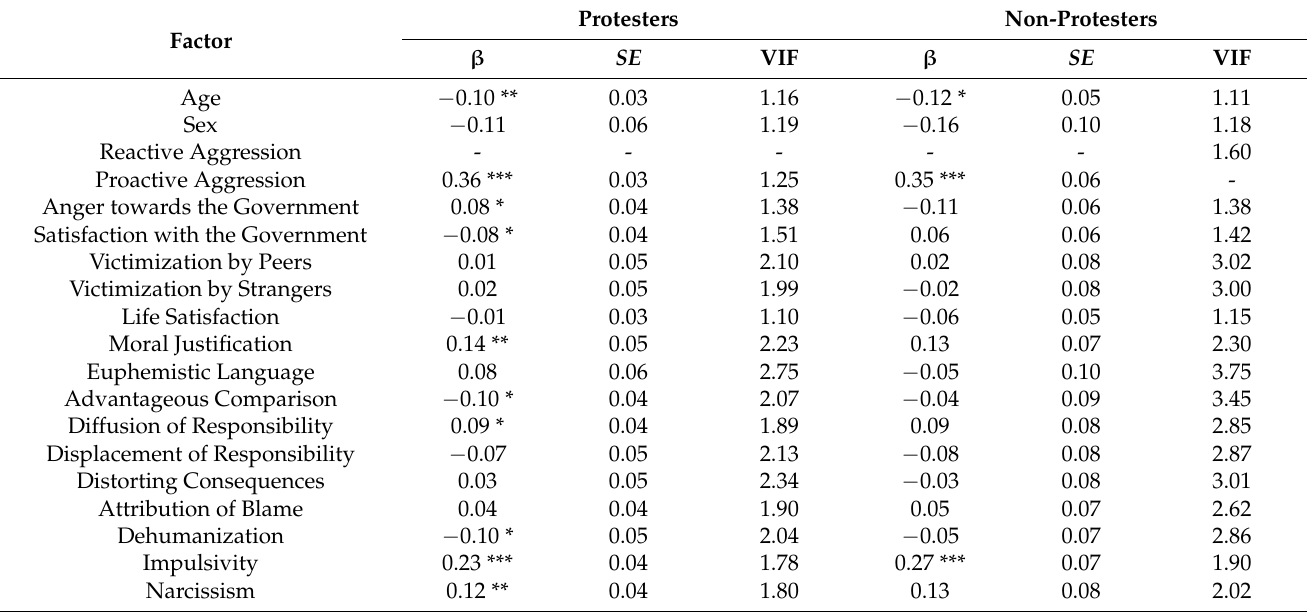
Table 7. Unconstrainted Model Predicting Reactive